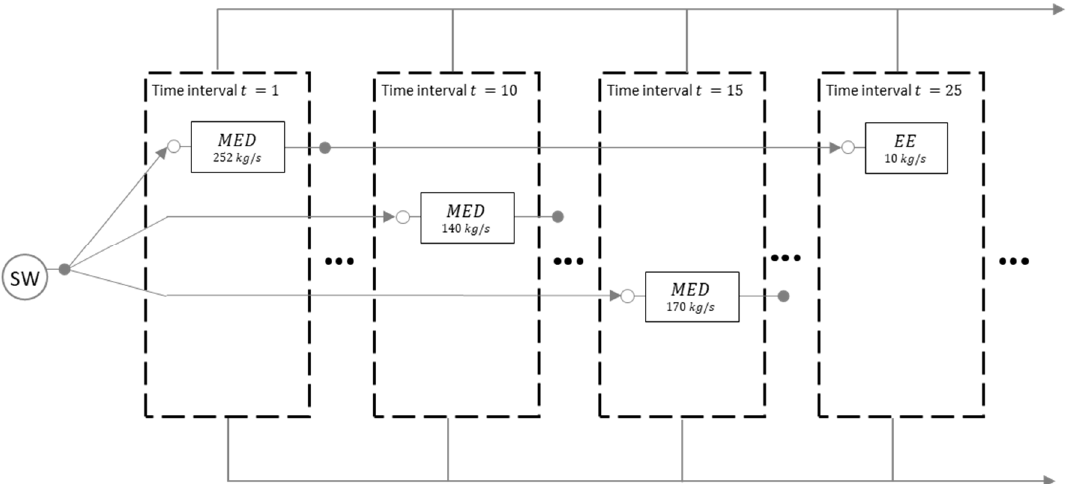
Figure 7. Processes 2018 , 6 , x FOR PEER REVIEW